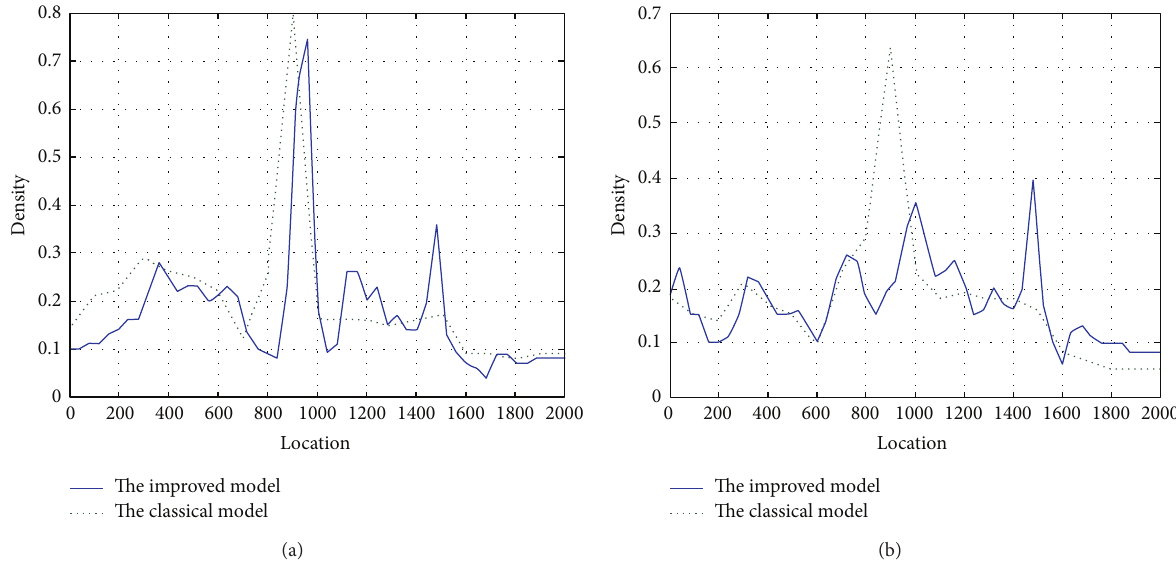
Figure 4: Density-distribution diagrams. (a) shows the density distribution in lane 1 and (b) shows the density distribution in lane 2.